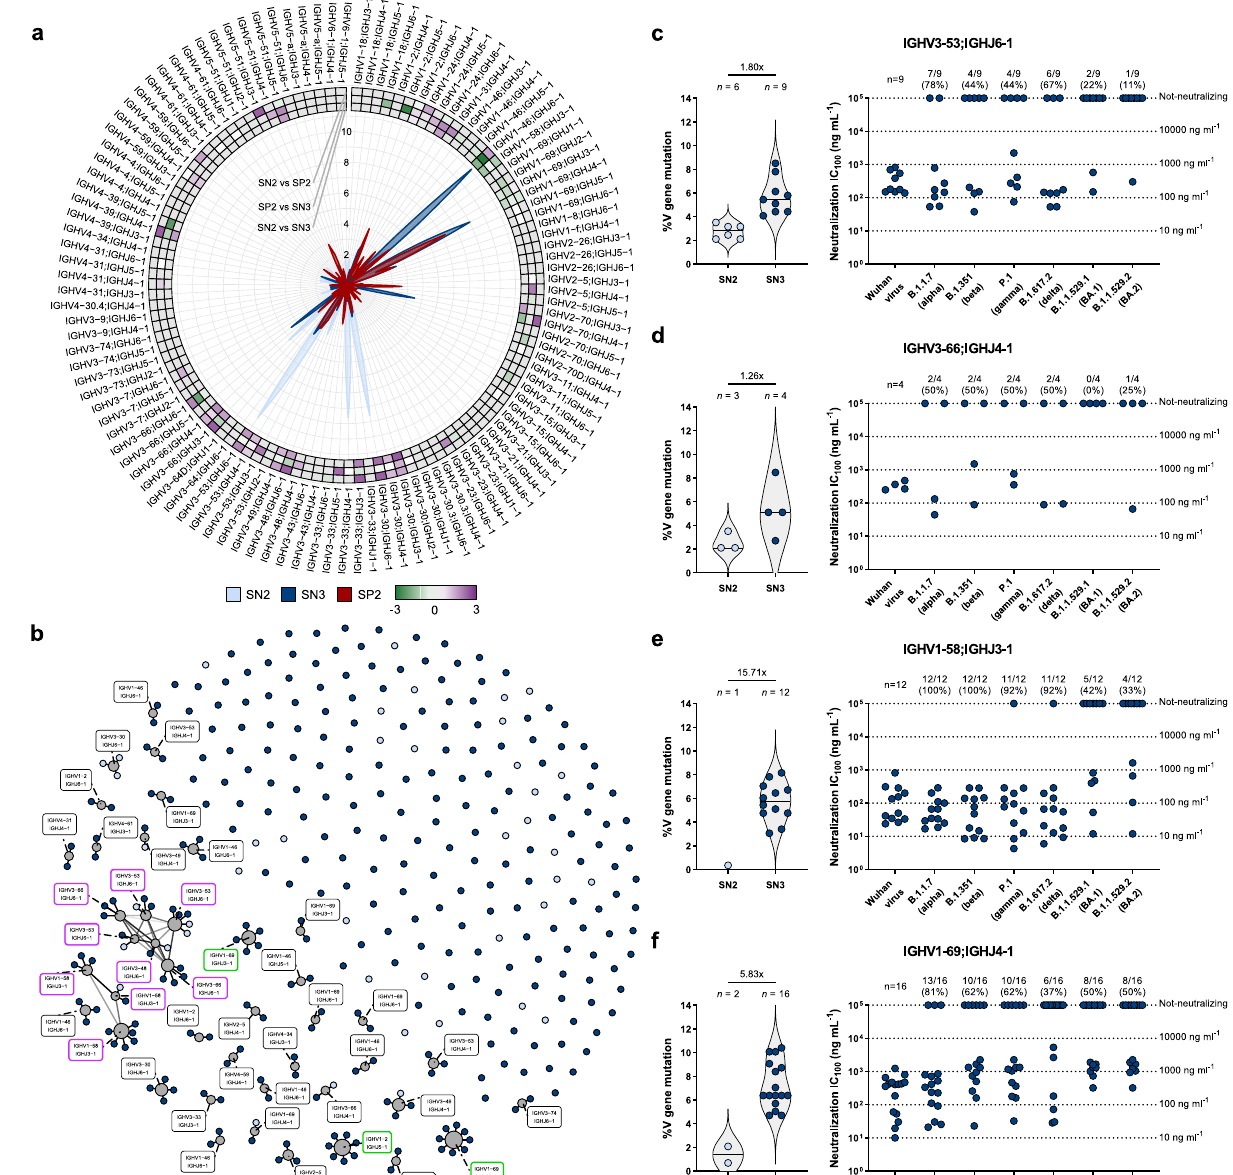
Fig. 3 | Repertoire analyses and characterization of predominant antibody germlines. a Radar plot shows the distribution of IGHV;IGHJ germlines among the three different groups. SN2, SN3, and SP2 are shown in light blue, dark blue, and red, respectively. Heatmap represents the Log2 fold change (FC) among groups. b Network plot shows the clonally-expanded antibody families in SN2 and SN3. Centroids and nAbs from SN2 and SN3 groups are shown in gray, light blue, and dark blue, respectively. Clusters and expanded clones are highlighted in bright